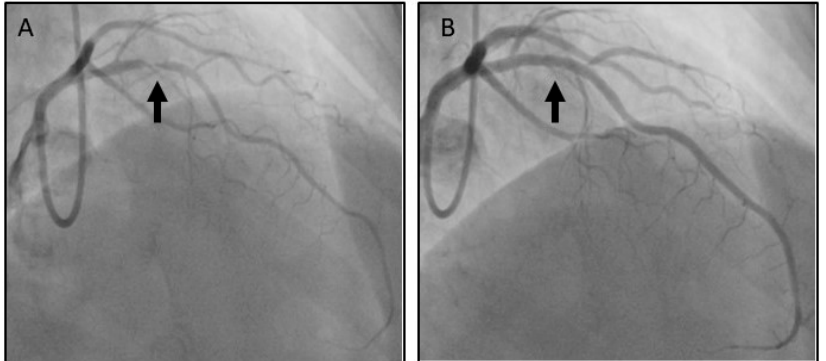
Figure 3. ( A ) Coronary angiogram showing severe proximal left anterior descending (LAD) lesion. ( B ) Coronary angiogram showing good angiographic result post-PCI. ( B ) Coronary angiogram showing good angiographic result